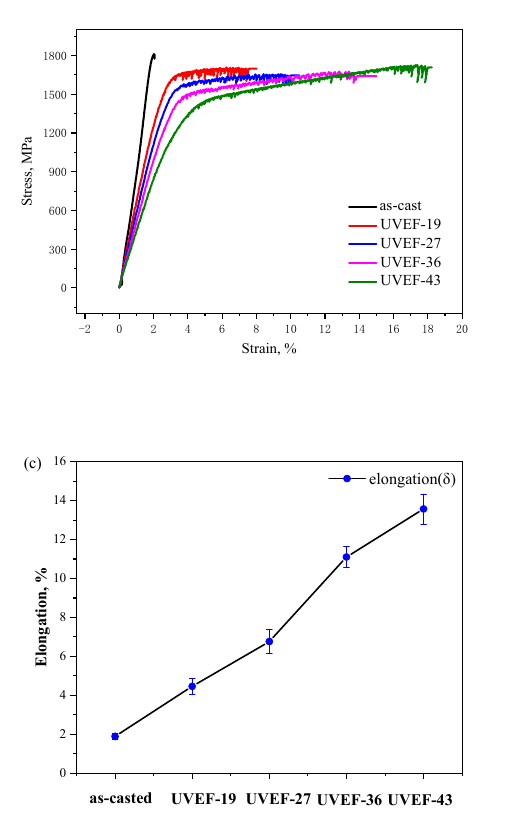
Figure 6. ( a ) Compression fracture stress–strain curves of as-cast and UVEF-treated samples ( b ) values of the yield stress and elastic modulus, and ( c ) elongation of the as-cast and UVEF treated samples.